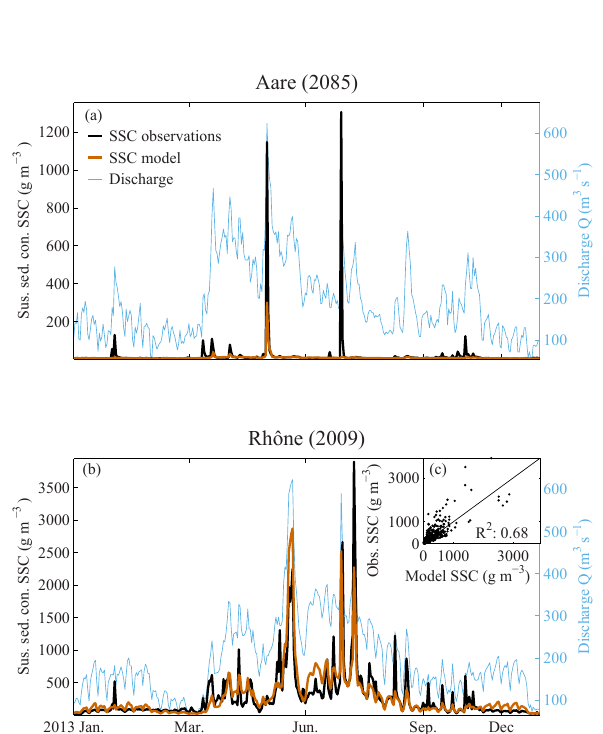
Figure 4. Modeled (orange) and measured (black) suspended sedi- ment concentration (SSC) compared to river discharge Q (blue) for (a) Aare River and (b) Rhône River in 2013. The insert (c) shows modeled versus observed SSC for 2013 and 2014 in the Rhône River with coefficient of determination ( R 2 ) .